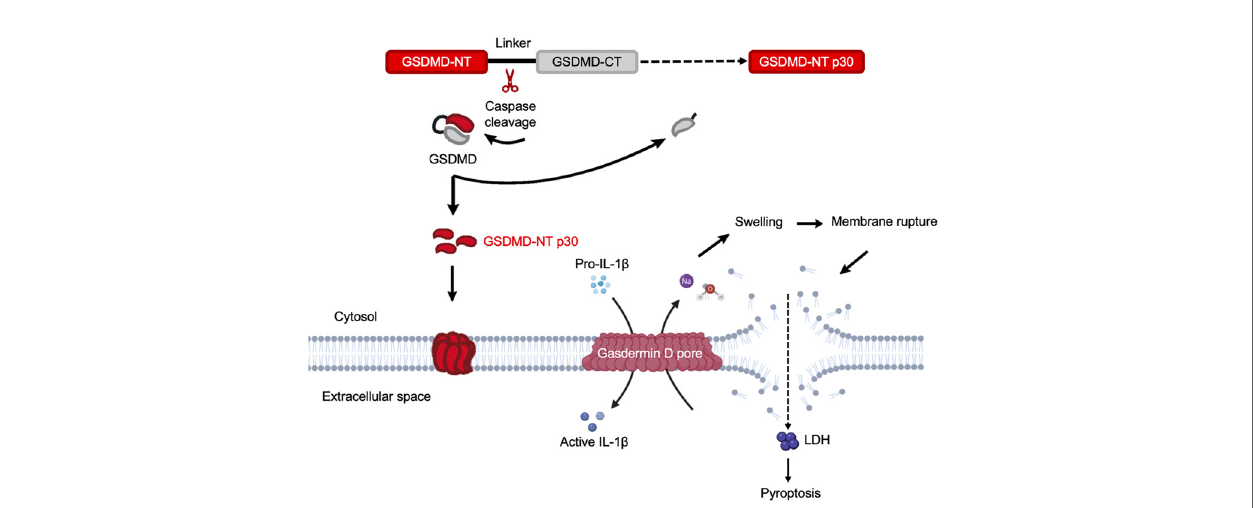
FIGURE 5 | Gasdermin D functions as the executor of cell pyroptosis. In fl ammatory caspases are activated by a wide array of in fl ammasomes upon sensing cytosolic contamination or perturbation. Upon activation, caspases cleave pro-IL-1 b , pro-IL-18, and GSDMD. Full length GSDMD is composed of an NT effector domain, also known as pore-forming domain (red) and a CT repressor domain (grey). These two components are connected by a fl exible link containing the caspase cleavage sites. The liberated NT pore-forming domain then inserts into the plasma membrane and triggers oligomerization of approximately 16 monomers to form a GSDMD pore. This is a relatively small pore allowing IL-1 b to release through it. Simultaneously, sodium gets into the cell, bringing along water that increases cell volume. This can rapidly exceed the volume capacity of the cell, causing a big tear in the plasma membrane that is much larger in size than the GSDMD pore. This membrane-rupture event results in massive release of soluble cytosolic contents, including lactate dehydrogenase